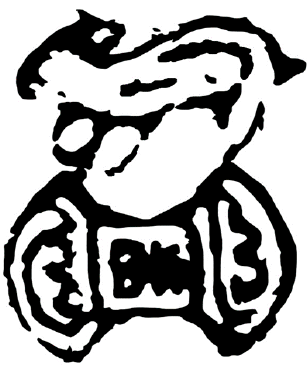
Figure 11. A Song Yuan Huaya with a Hare motif and an ingot. The Song Dynasty. Inventory number: 114. Sketched by author. Picture source: Wang (1990), p. 46.